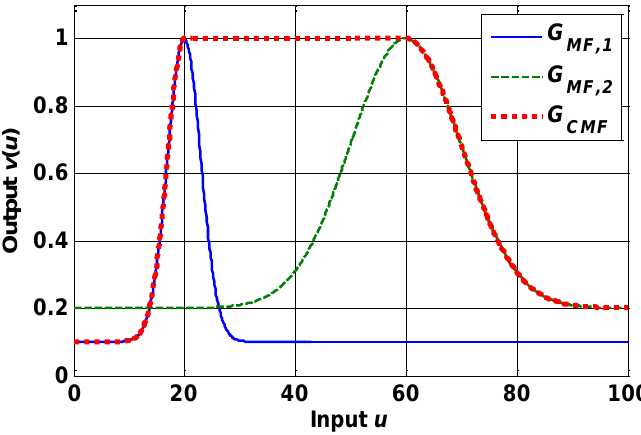
Figure 6. Example of a Gaussian combination membership function (dotted line) based on two modified Gaussian membership functions G